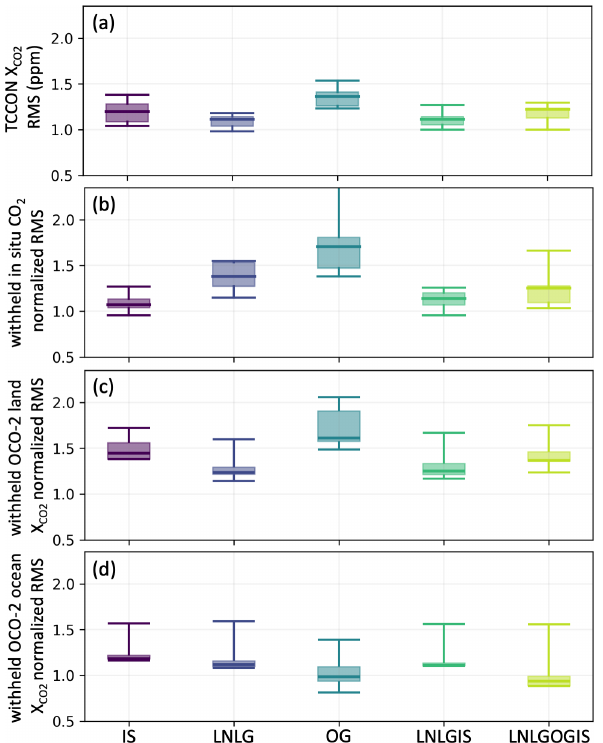
Figure 5. 2015–2020 root mean square error (RMSE) between the v10 OCO-2 MIP experiments and (a) TCCON X CO (b) withheld in situ CO 2 measurements, (c) withheld OCO-2 land X CO retrievals, and (d) withheld OCO-2 ocean X CO 2 For the comparisons with withheld in situ and OCO-2 observations, the normalized RMSE estimate is plotted (that is, the observation– model mismatch is divided by the observational uncertainty). Note that NIES IS and CSU co-samples are not available and not included in this